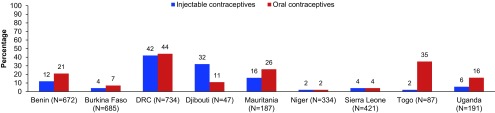
Percentage of Health Facilities With Stock-Outs of Injectable and Oral ContraceptivesAbbreviation: DRC, Democratic Republic of the Congo.Percentage stock-out refers to the proportion of facilities providing family planning services, where a SARA surveyor did not observe at least 1 valid stock of injectable or oral contraceptives in the service area or in the place where they are routinely stored in the health facility, on the day of the assessment.